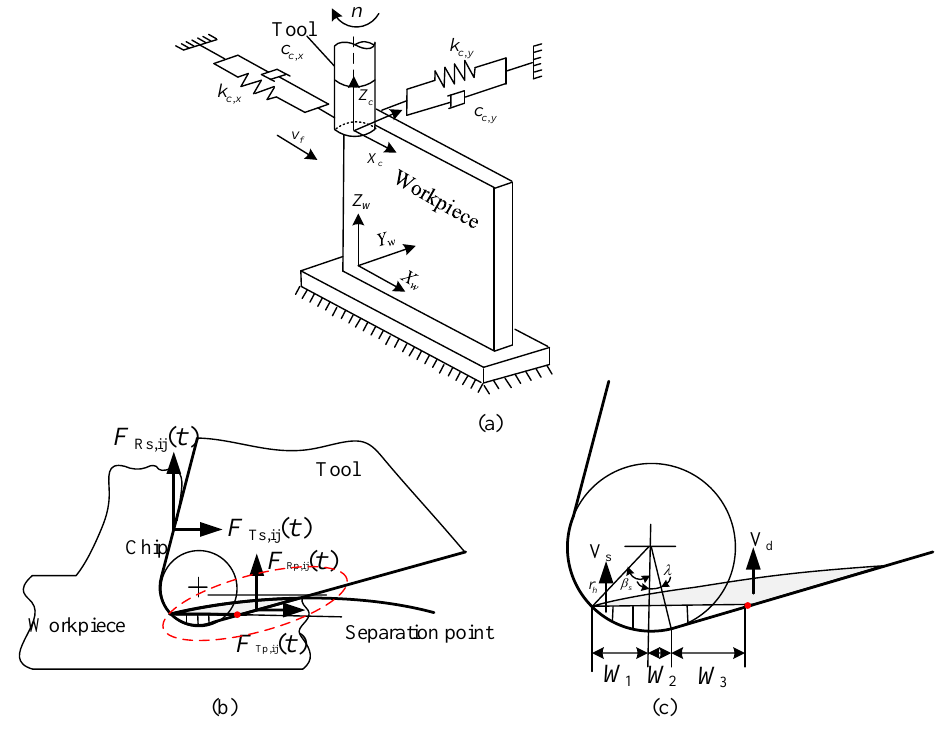
Figure 1. Dynamic model of milling system. ( a ) Three-dimensional model, ( b ) Schematic of chip generation, ( c ) Area of the indented volum.